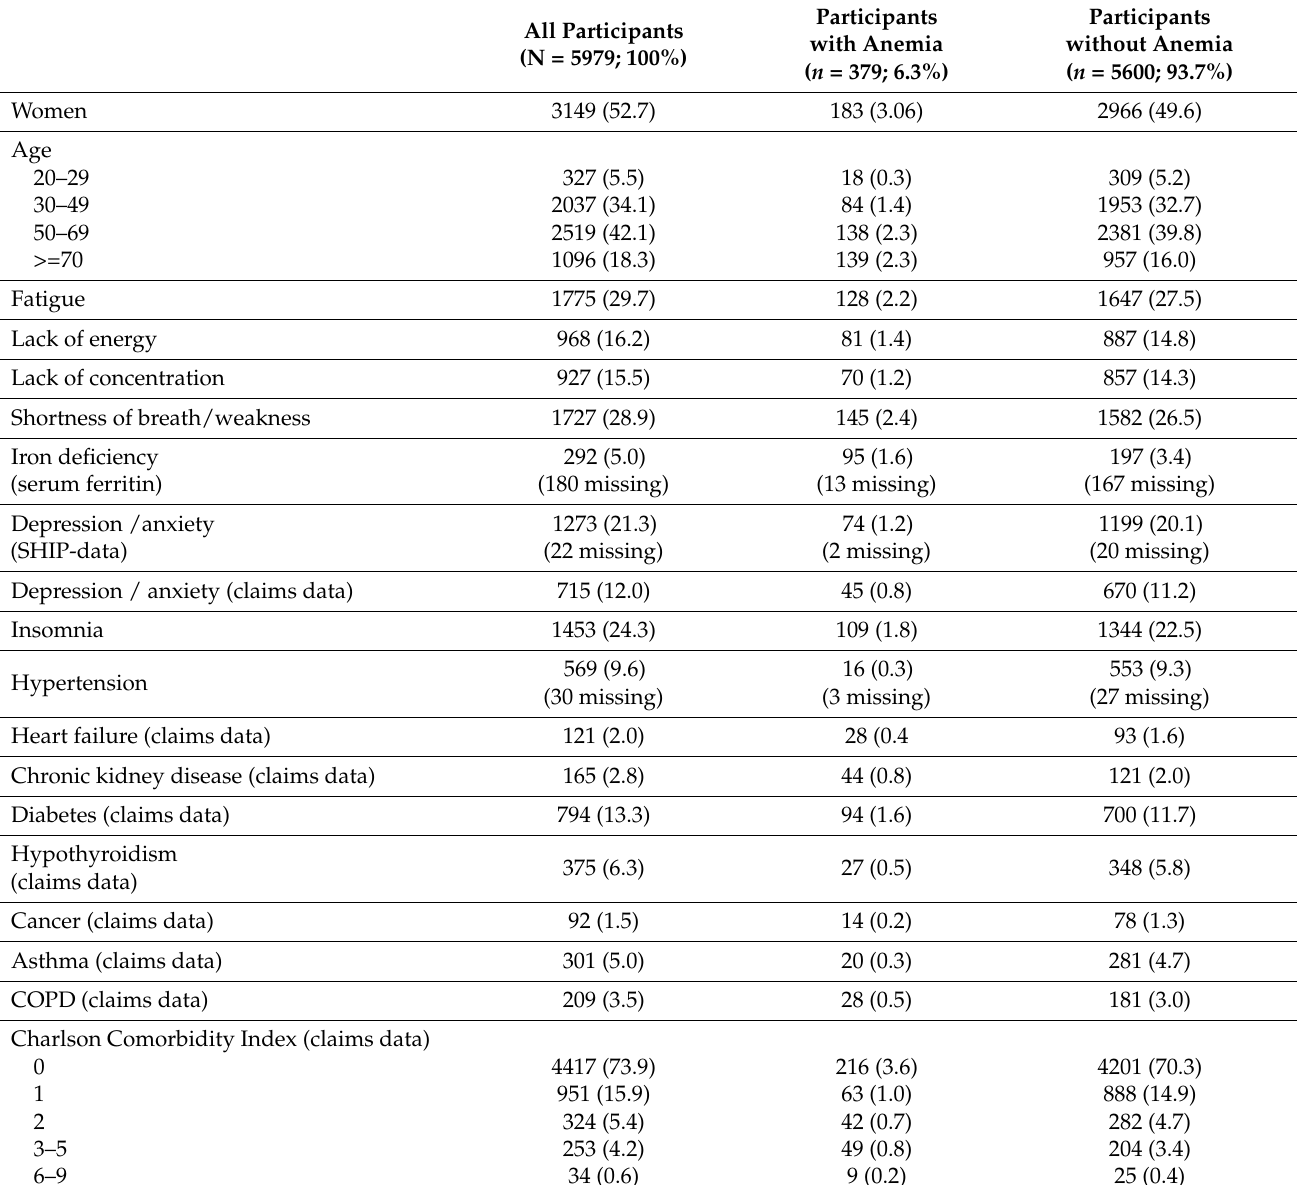
Table 3. Characteristics of all study participants and participants according to anemia